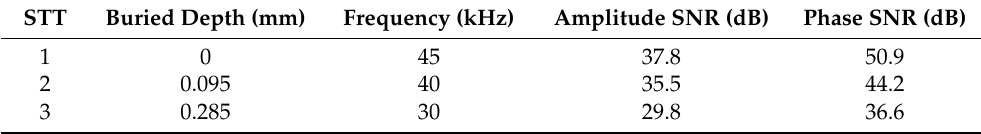
Figure 19. Relation of the amplitude and phase signals to crack depth for flaws buried at h = 0, 0.095, and 0.285 mm on an aluminum specimen. ( a ) The change in the amplitude signal and ( b ) the change in the phase signal. Table 3. SNR in amplitude and phase for a 1.8 mm deep crack buried at different